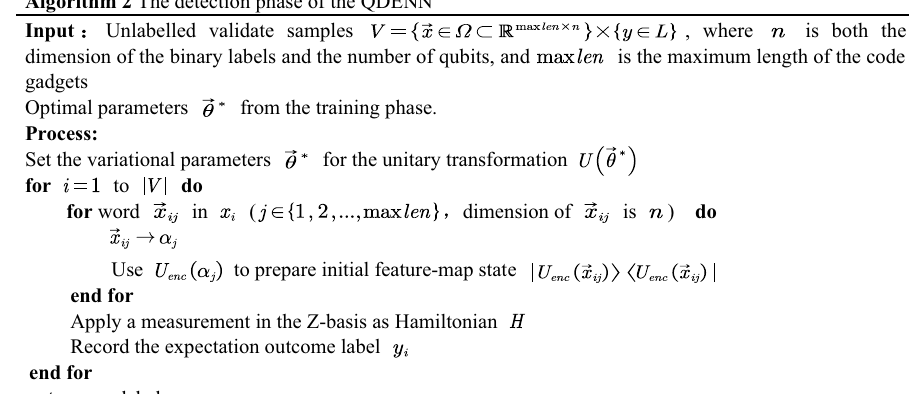
Algorithm 2 The detection phase of the